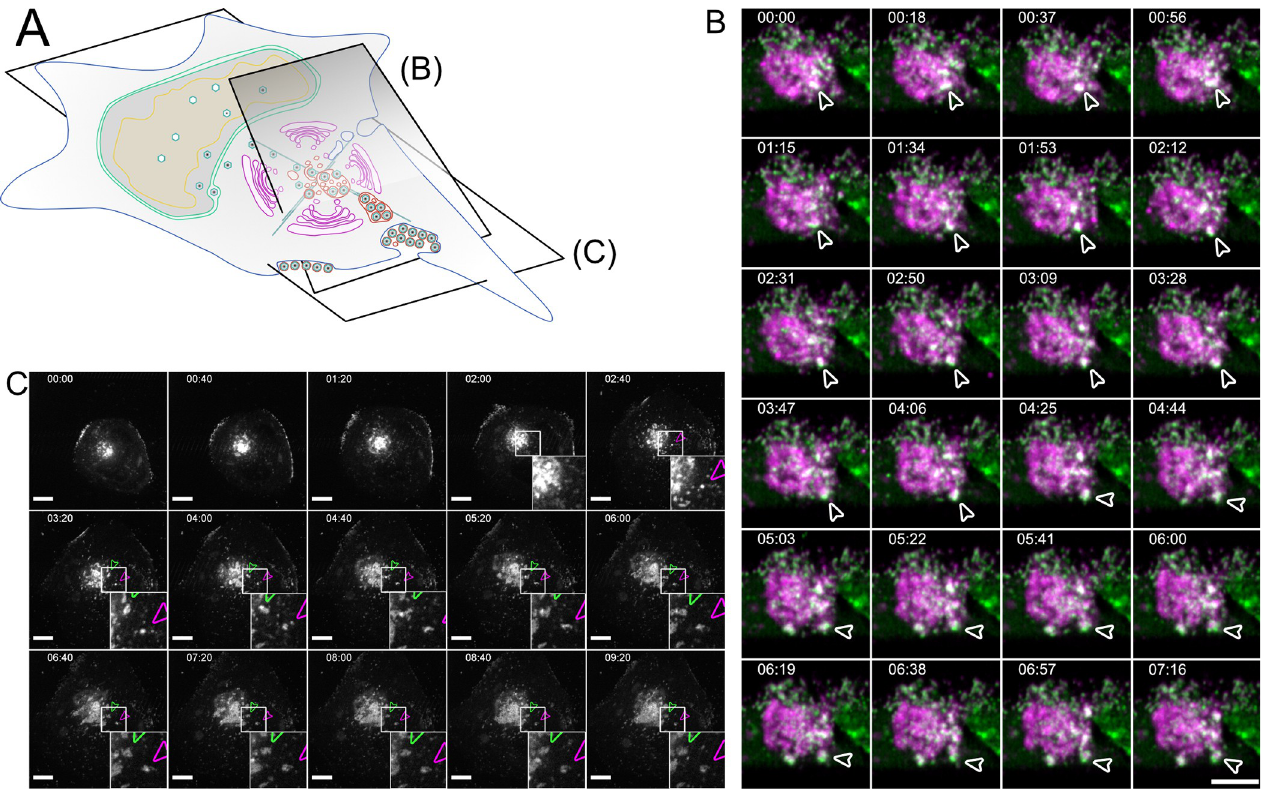
Fig 3. Bulk release from MViBs leads to EVA formation. 3A Overview indicates the subfigures’ positions in relation to the whole cell. 3B HFF cells were infected with HCMV-pp150-EGFP-gM-mCherry at an MOI of 1. At 96 hpi, the cells were imaged by lattice light-sheet microscopy, taking whole-cell volumes every 2.11 seconds at a 30˚ angle to the growth substrate. Maximum projections of 20 slices with a total depth of 2 μ m of an area under the viral AC and incorporating the plasma membrane are shown. White arrowheads highlight an MViB positive for pp150-EGFP (green) and gM-mCherry (magenta) that approaches the plasma membrane and fuses with it. Also, refer to Supplementary Video 5 in https://doi.org/10.5281/zenodo.6611135 for a rendering and several side views. 3C HFF cells were infected with HCMV-pp150-SNAP-gM-mScarlet-I at an MOI of 1. At 72 hpi, cells were imaged live with confocal spinning-disk microscopy. Only the gM-mScarlet-I channel is shown. Both channels can be seen in Supplementary Video 7 in https://doi.org/10.5281/zenodo. 6611135. The formation of two EVAs is highlighted with white arrowheads. Scale bar indicates 10 μ m. The time format is hh:mm. Also, refer to Supplementary Videos 6 and 7 in